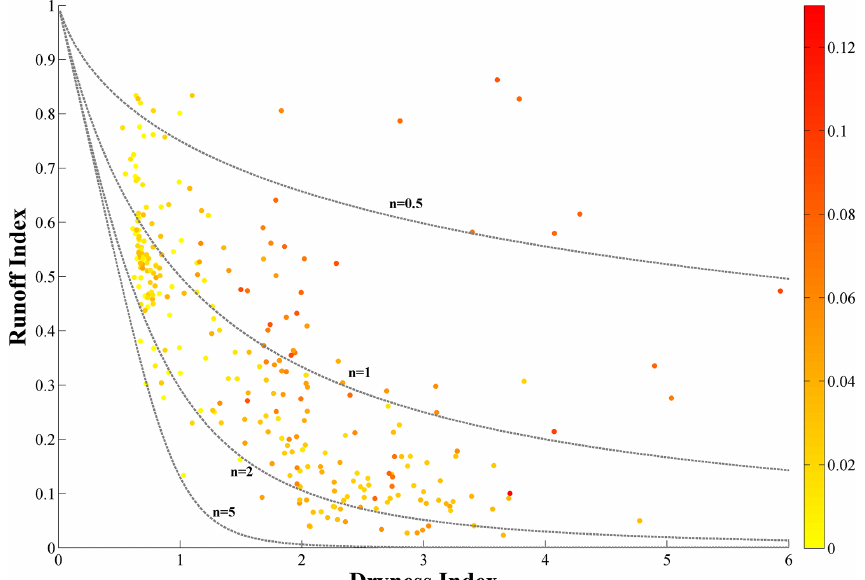
Figure 2. The 282 long-term climatological water budget observations in China. Each point represents a catchment. The color refers to the snow ratio. Dashed lines are derived from Eq. (7) with different n